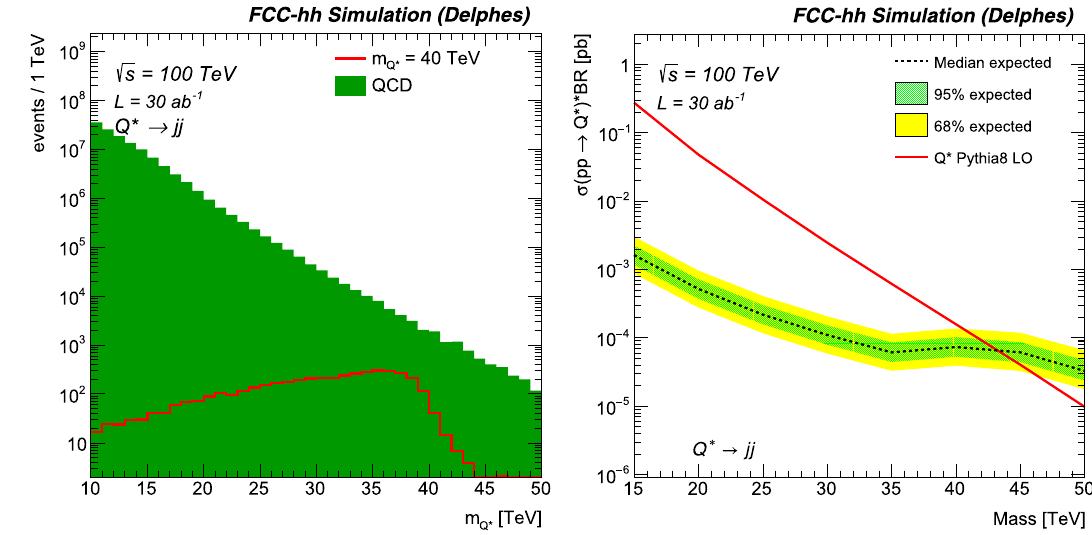
Fig. 6 Invariant mass distribution of the two selected jets for a 40TeV signal (left), 95% CL limit versus mass